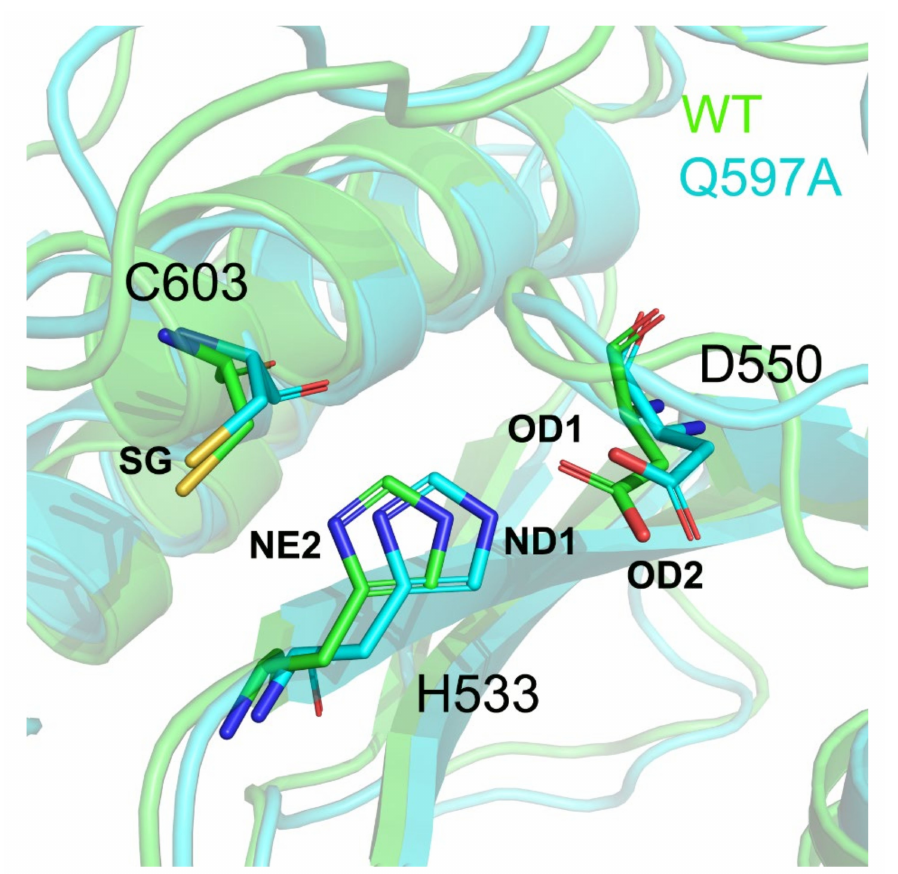
Figure 8. Structural superimposition of the SENP1 catalytic triad Cys603, His533, and Asp550 in the WT and Q597A systems.